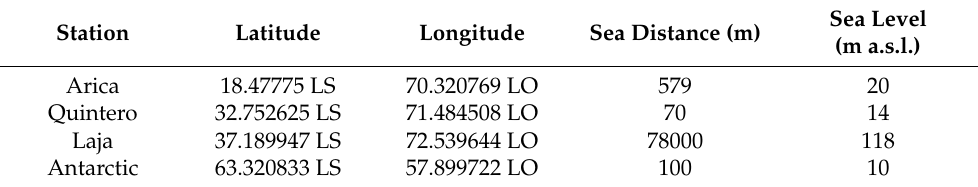
Table 2. Geographic locations of atmospheric